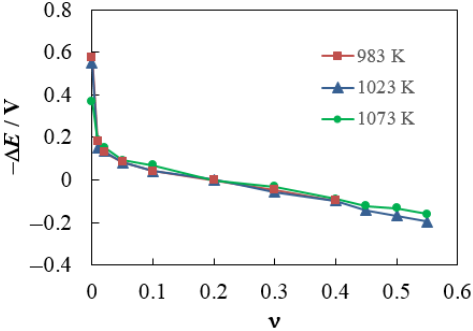
Figure 3. Experimental dependences of the potential difference in Cell (4) on the WO 3 mole fraction in the (1– ν )Na 2 WO 4 – ν WO 3 melt at 983, 1023 and 1073 K.